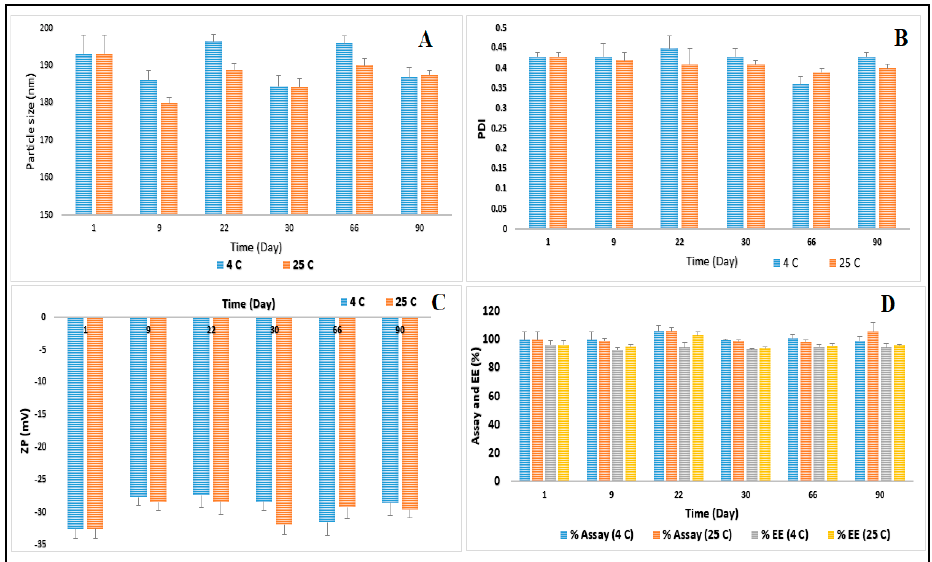
Figure 1. ( A ) particle size, ( B ) polydispersity index, ( C ) zeta potential, and ( D ) assay and entrapment efficiency of optimized CIP-NLC formulation over three months storage at 4 ± 2 °C and 25 ± 2 °C (mean ± SD, n = 3).